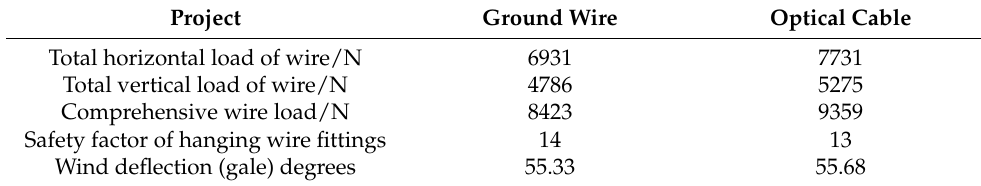
Table 2. Designed parameters of the Tu-ha Line II.